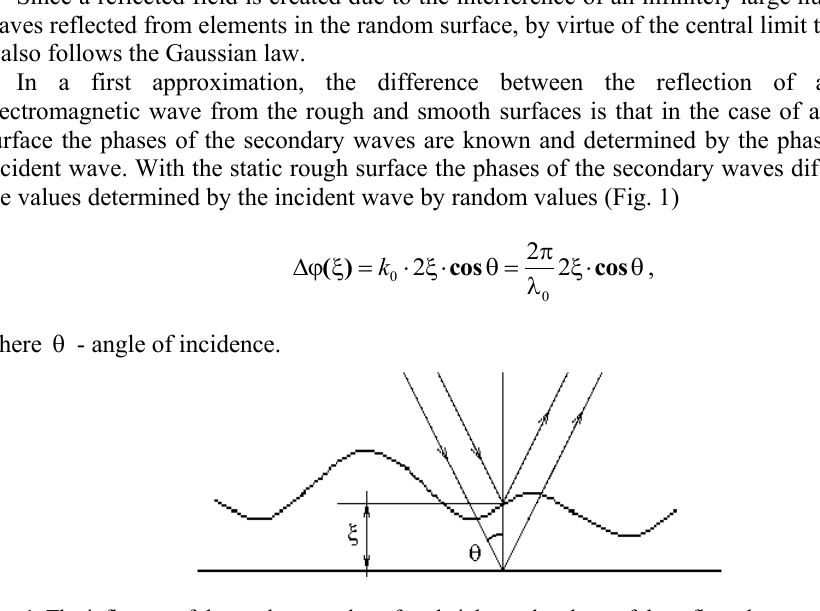
Fig. 1. The influence of the random rough surface height on the phase of the reflected